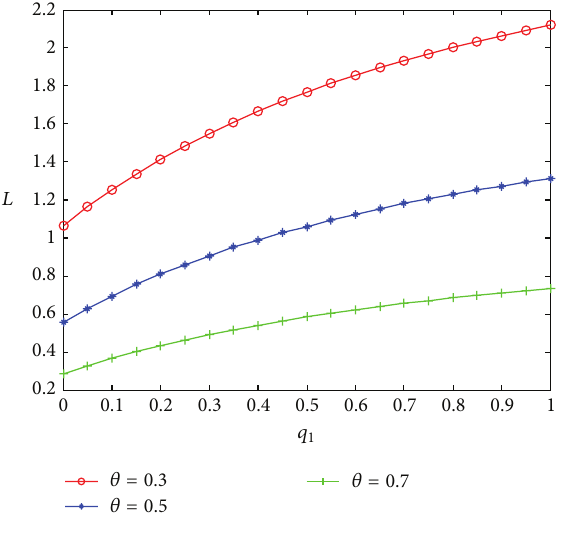
Figure 1: The effect of 𝑞 1 on 𝐿 . Figure 2: The effect of 𝜇 1 on 𝐿 .